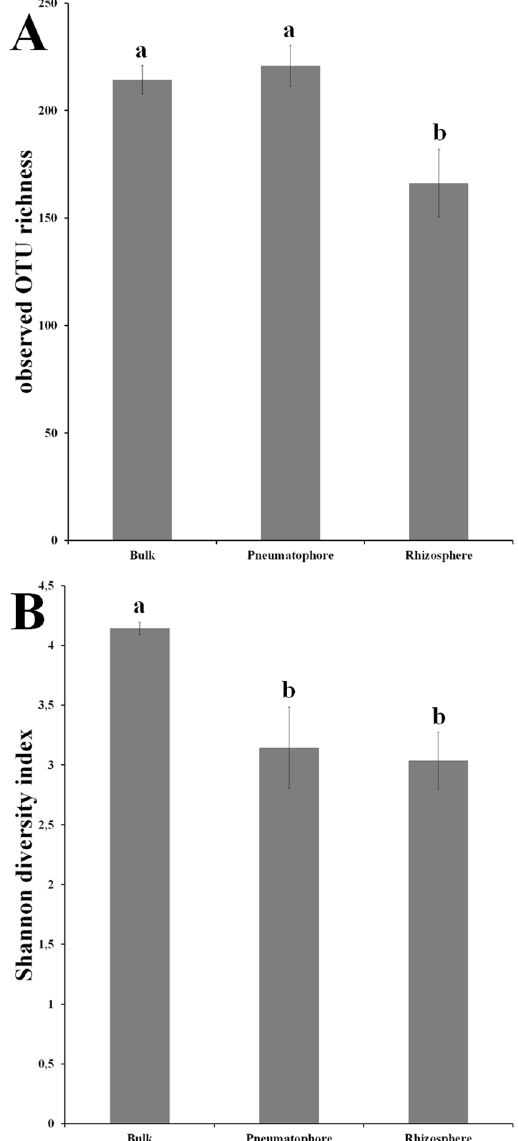
Figure 3. Observed OTU richness ( A ), and Shannon diversity index ( B ) of ITS fungal OTUs in bulk, pneumatophore and rhizosphere soil compartments. OTUs were clustered at 97% similarity level. The different alphabet denotes significance at 0.05 (ANOVA; Post-Hoc test: Tukey